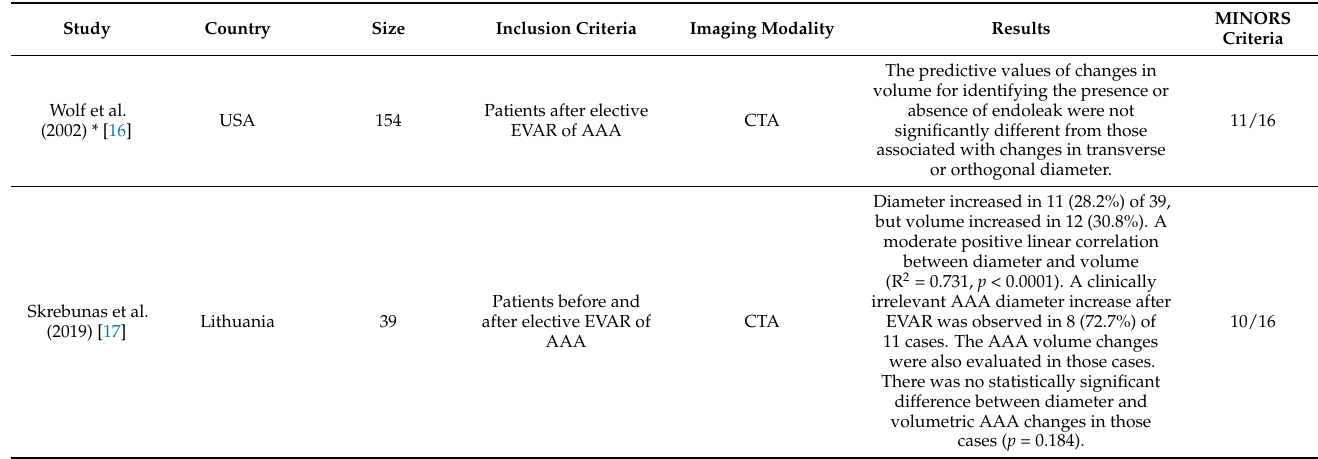
Table 3. Summary of studies that found no difference in diagnostic and prognostic values of volume and diameter